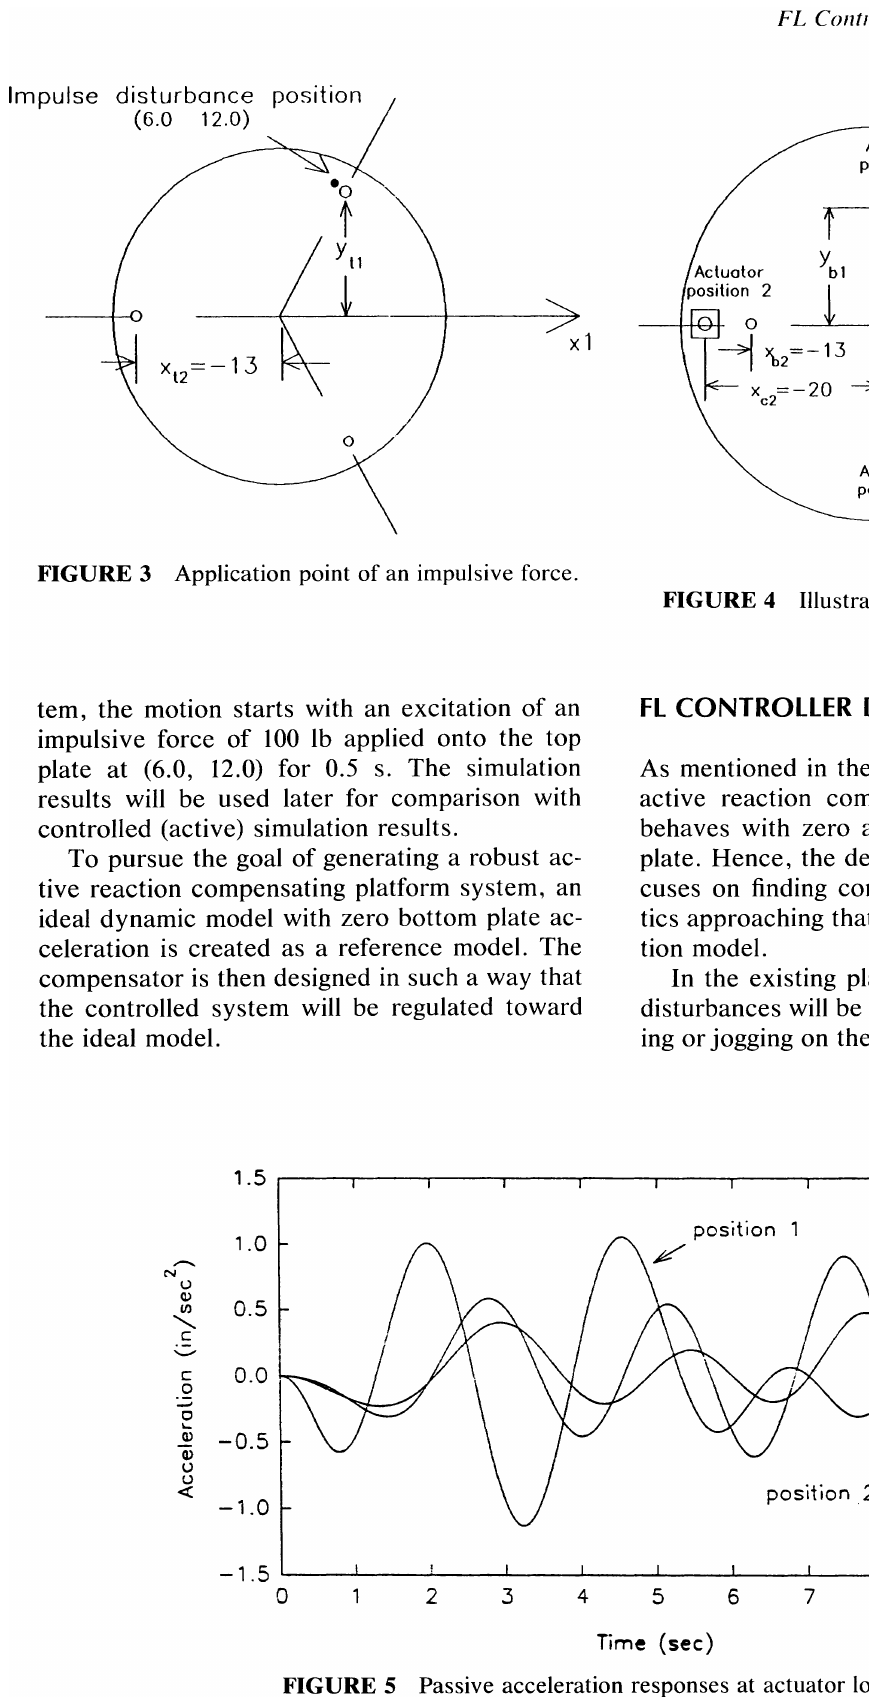
FIGURE 5 Passive acceleration responses at actuator